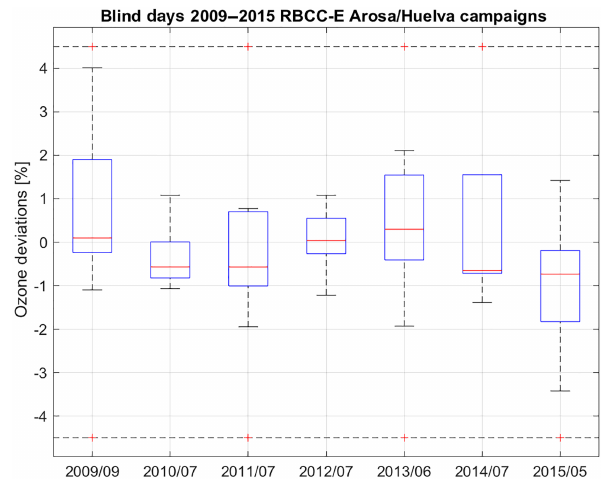
Figure 14. Ozone deviations for the blind days with respect to the reference Brewer for the simultaneous direct sun measurements for all the participating instruments during the RBCC-E regular campaigns 2009–2015. The campaigns performed in odd years correspond to Arosa (Switzerland) and in even years in Huelva (Spain). These results correspond to the stray-light-free region OSC < 700DU; the outliers (red cross at ± 4.5% levels) generally correspond to non-operating